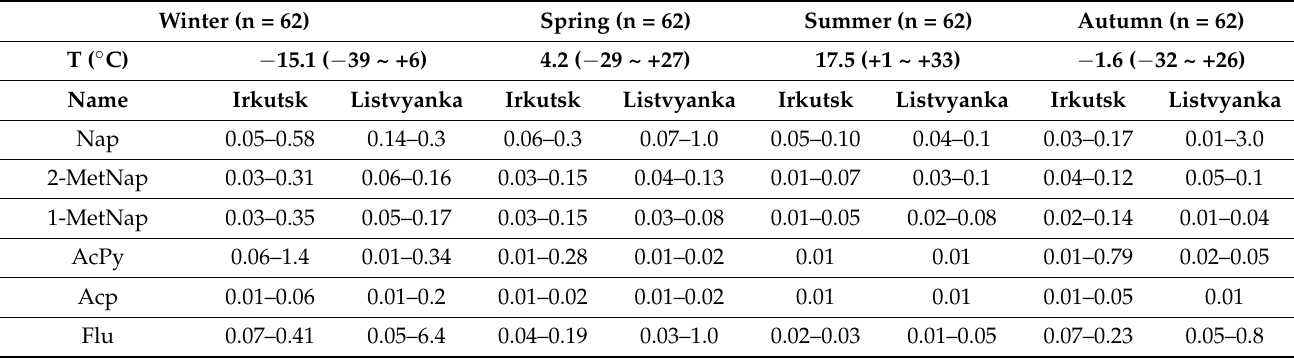
Table 1. Minimum and maximum concentrations of PAHs (ng · m − 3 ) in aerosols from Irkutsk and Listvyanka in different seasons from 2015 to 2021. Average seasonal temperature (C ◦ ) in the region and extremal range (min ~ max C ◦ ) during the measurements.